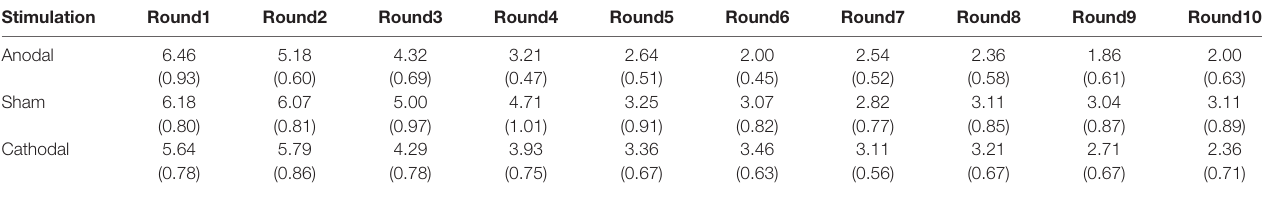
TABLE 2 | Means and SE of the data for estimated contributions in public good games under three conditions. Stimulation